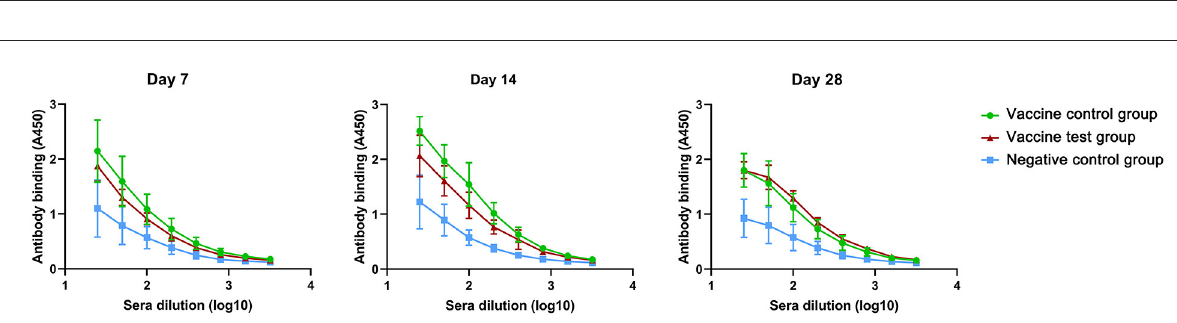
SARS-CoV-2 (B.1.617.2) with